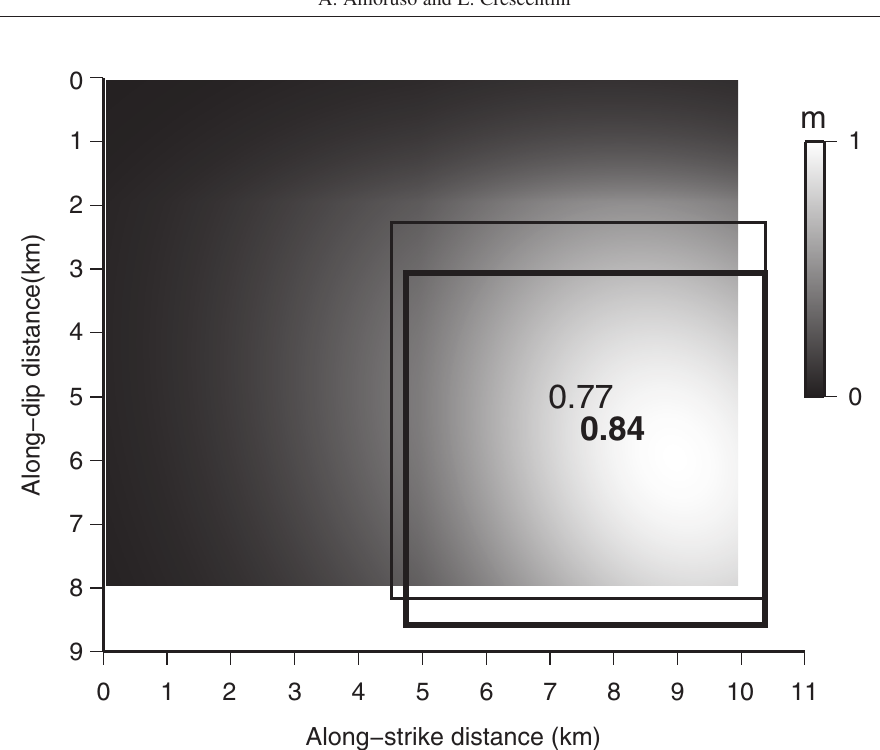
Fig. 4. Best fit uniform-slip fault in the HHS (thin-line rectangle) and LHS (tick-line rectangle) over the dis- tributed-slip source fault. Numbers give